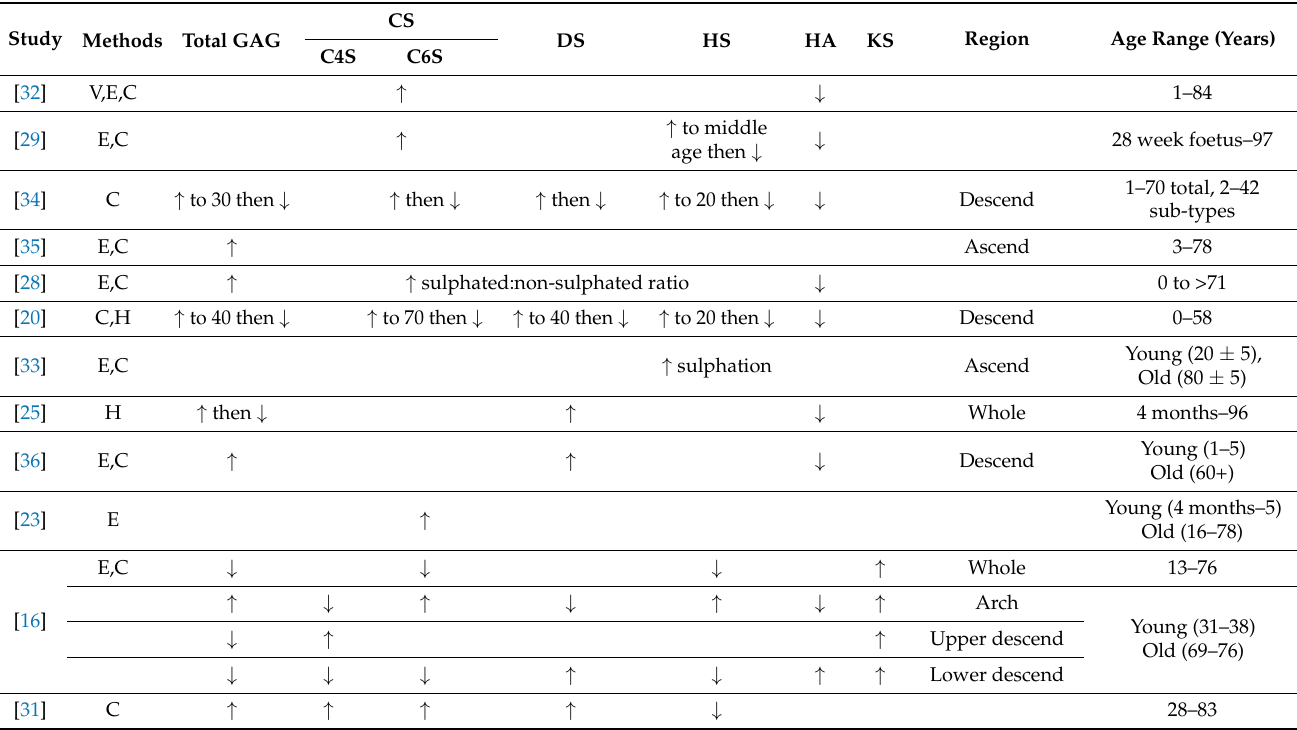
Table 2. Studies reporting age-associated changes in GAG levels. Reported increases ( ↑ ) and decreases ( ↓ ) are shown for total GAG and subtypes: chondroitin-4-sulphate (C4S), chondroitin-6- sulphate (C6S), dermatan sulphate (DS), heparan sulphate (HS), hyaluronic acid (HA) and keratan sulphate (KS). Methods used for analysis: viscometry (V), electrophoresis (E), chromatography (C) or histology (H) are shown. The region of the aorta used for analysis (ascending or descending) and the age range included in the study are also